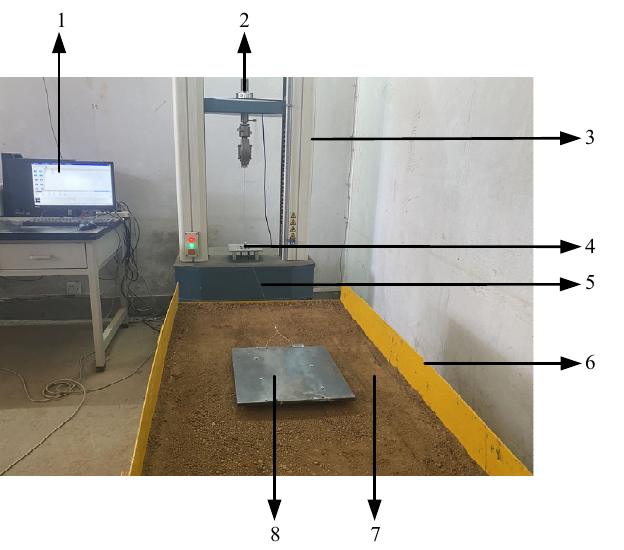
Figure 8. Tire-pattern test system consists of: 1. computer, 2. tension sensor, 3. electronic universal tensile-tester, 4. fixed pulley, 5. Traction wire-rope. 6. soil groove, 7. soil, 8. bionic pattern.